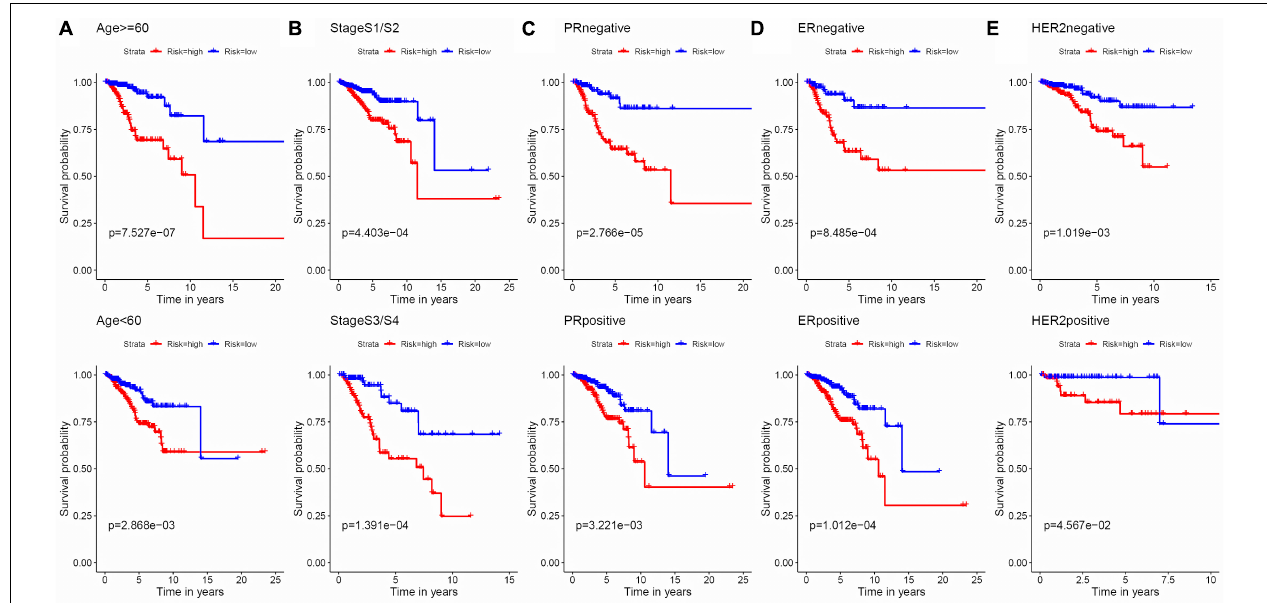
FIGURE 5 | Kaplan–Meier survival analysis of the 8-APA-event risk score level for RFS in different subgroups. (A) Age < 60, Age ≥ 60. (B) Stage 1/2, Stage 3/4. (C) PR negative, PR positive. (D) ER negative, ER positive. (E) HER2 negative, HER2